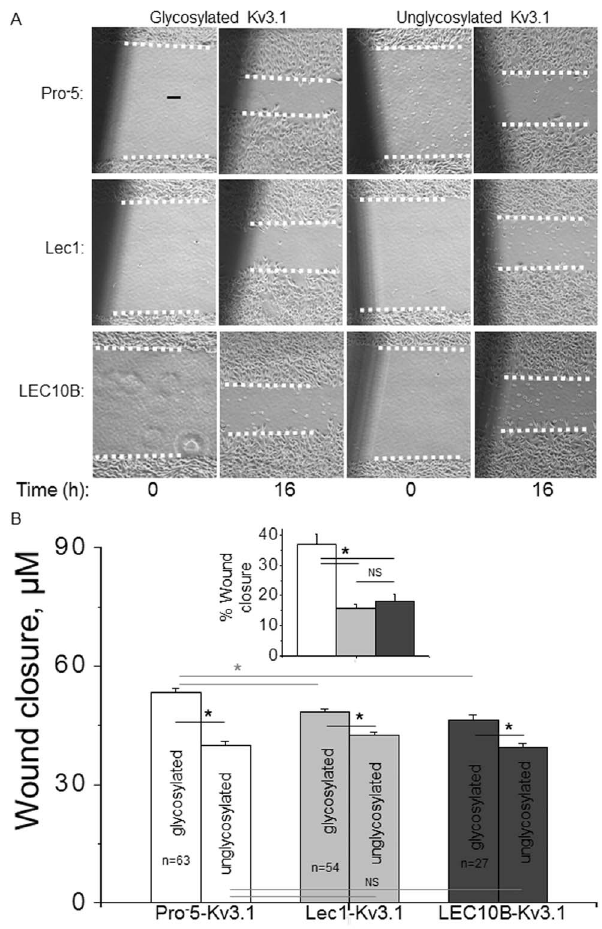
Figure 5. Rate of CHO cell migration is enhanced by Kv3.1. Cell wounds were generated for glycosylated and unglycosylated Kv3.1, and then images were captured at 0 and 16 h time points for Pro - 5 (top row), Lec1 (middle row), and LEC10B (bottom row) (A). Rate of cell wound closure was determined for glycosylated and unglycosylated Kv3.1 expressed in the various CHO cell lines (B). Region of wound measured is indicated by the two dotted white lines per image. The percent of wound closure is the increase in wound closure due to the N - glycan attached to Kv3.1 (B, inset). Asterisks indicate significant differences in mean values at a probability of P ,